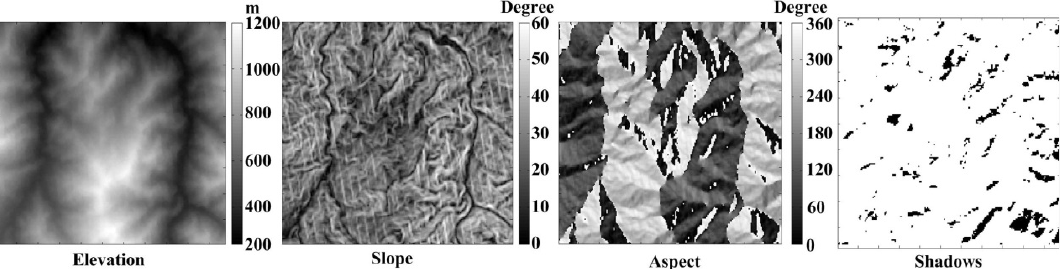
Figure 3. The topographic factors derived from the digital elevation model (DEM). The black areas in “Shadows” represent that the canopies do not receive the direct solar radiation.